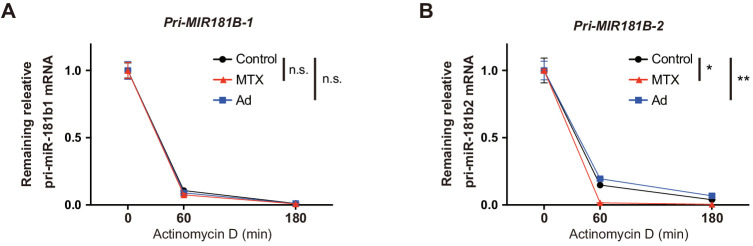
The effect of methotrexate (MTX) and Ad on pri-MIR181B-1 and pri-MIR181B-2 transcript stability.HUVECs were incubated with 10 µg/ml Actinomycin D to inhibit transcription and treated with 10 µM MTX or 50 µM Ad. (A) Real-time qPCR analysis of pri- MIR181B-1 transcript expression at indicated time points. (B) Real-time qPCR analysis of pri- MIR181B-2 transcript expression at indicated time points. (A) and B), n = 3. *p<0.05, **p<0.01. All values represent mean ± SEM.